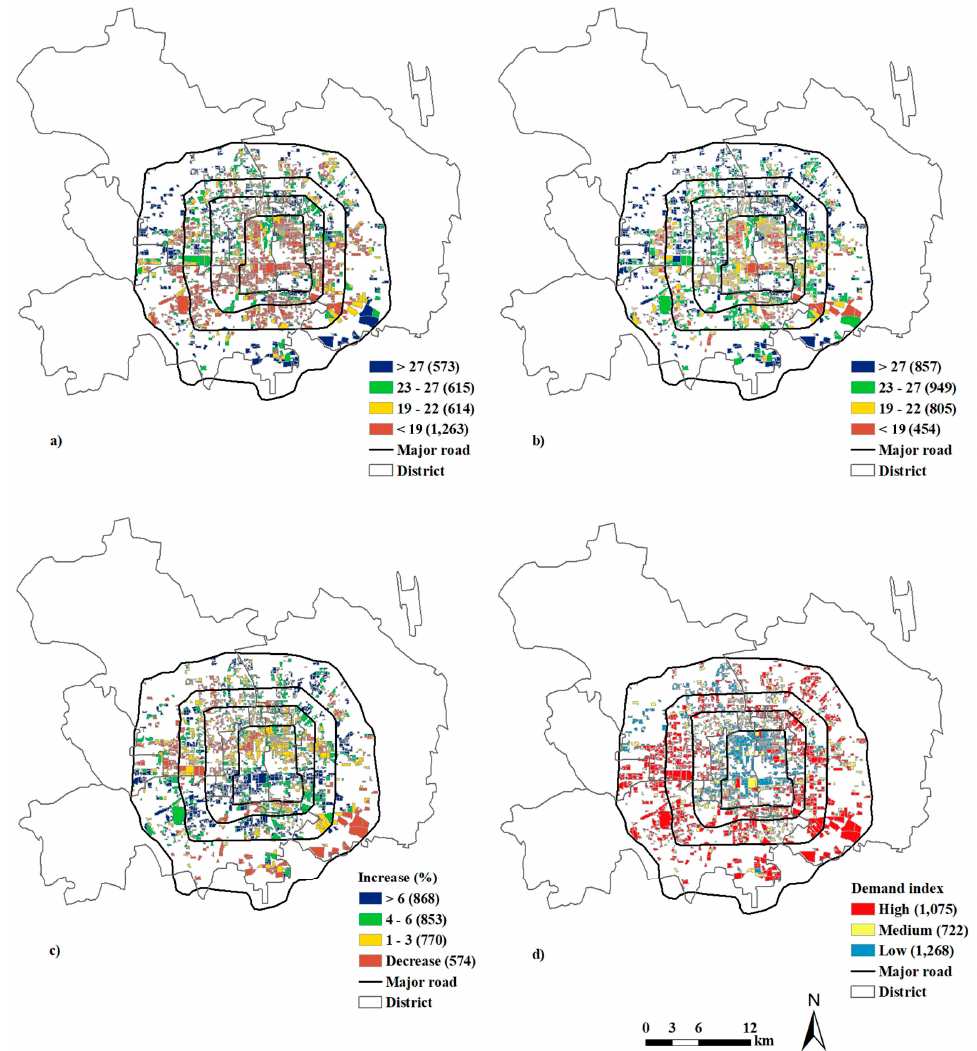
Figure 8. Greenspace supply and demand by neighborhood. a ) Accessible greenspace of neighbor- hood in 2005 (%); b ) Accessible greenspace of neighborhood in 2015 (%); c ) Accessible greenspace change of neighborhood from 2005–2015; d ) Demand level of greenspace by neighborhood.